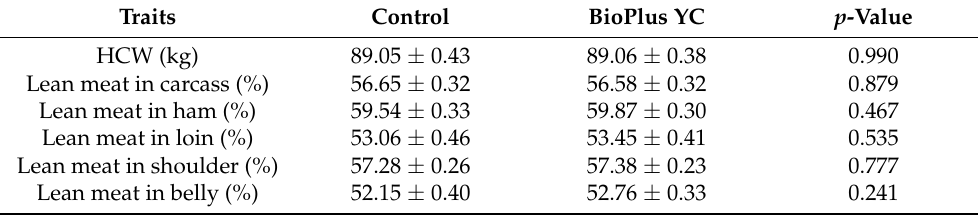
Table 5. Slaughter carcass value.